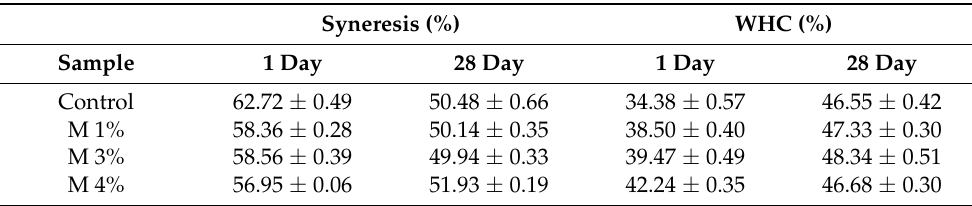
Table 5. Syneresis and WHC in control sample (Control) and samples with moringa extract addition (1, 3 and 4% of extract addition, M 1%, M 3%, M 4%) at the 1st and 28th day of cold storage.